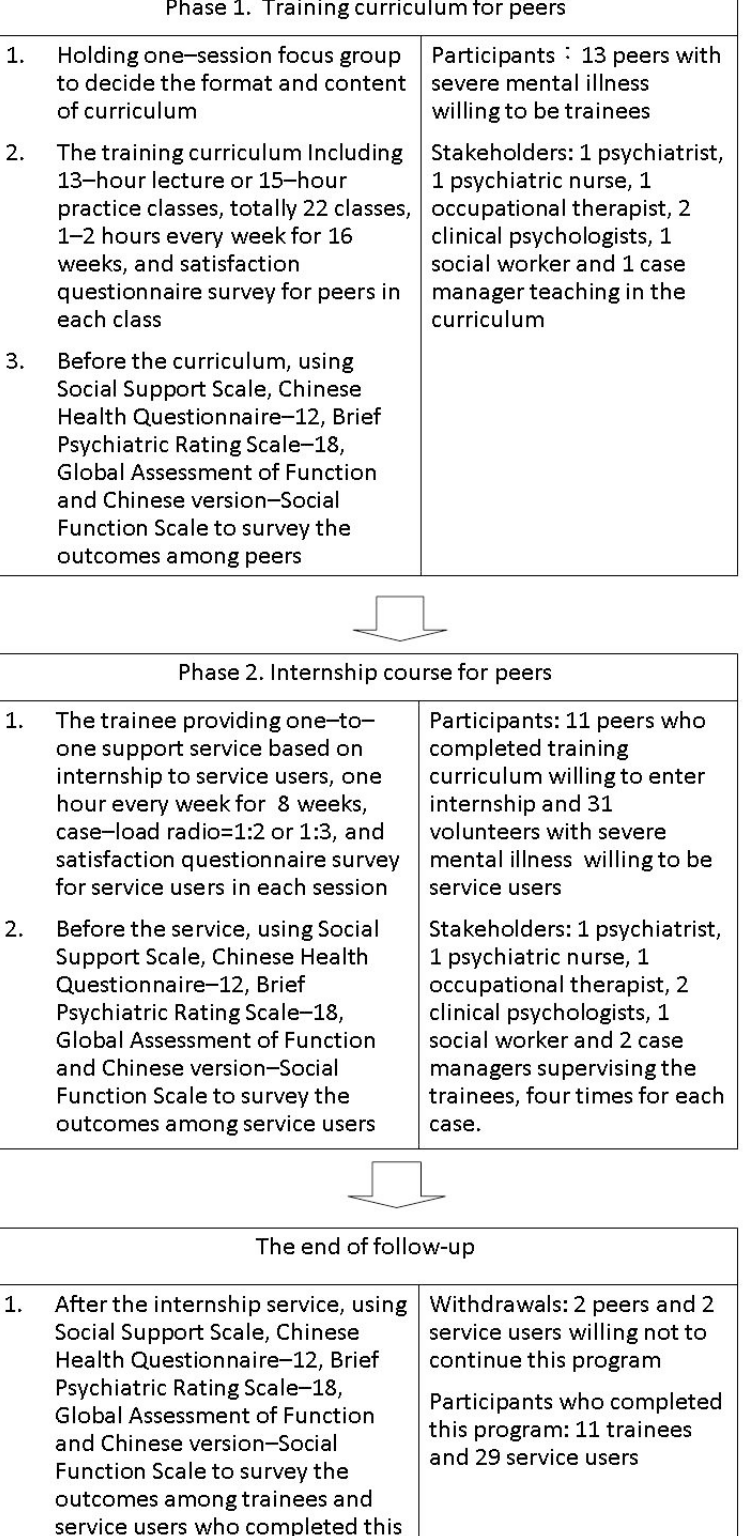
Figure 1. The process of this pilot